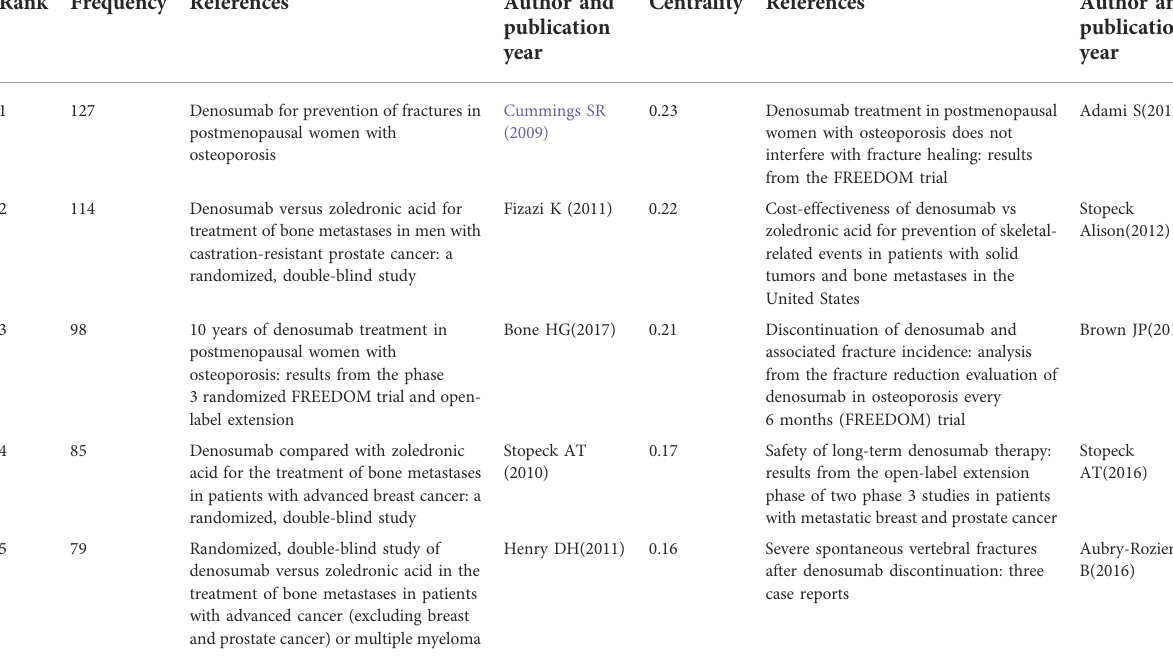
TABLE 5 Top 5 references in terms of citation frequency and centrality.